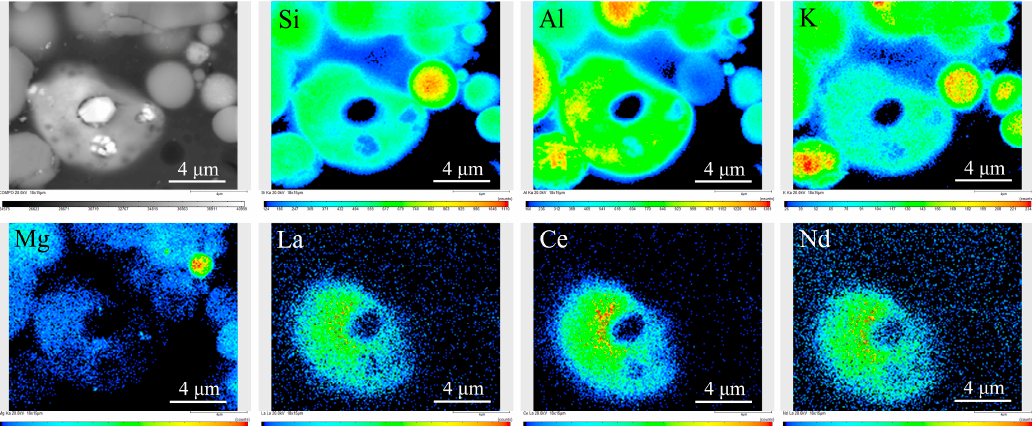
Figure 5. EPMA-WDS quantitative elemental mapping of the coal fly ash sample. The scale bar is 4 µm. Analysis conditions: 20 kV, 45 nA, and a map dwell time of 250 ms.